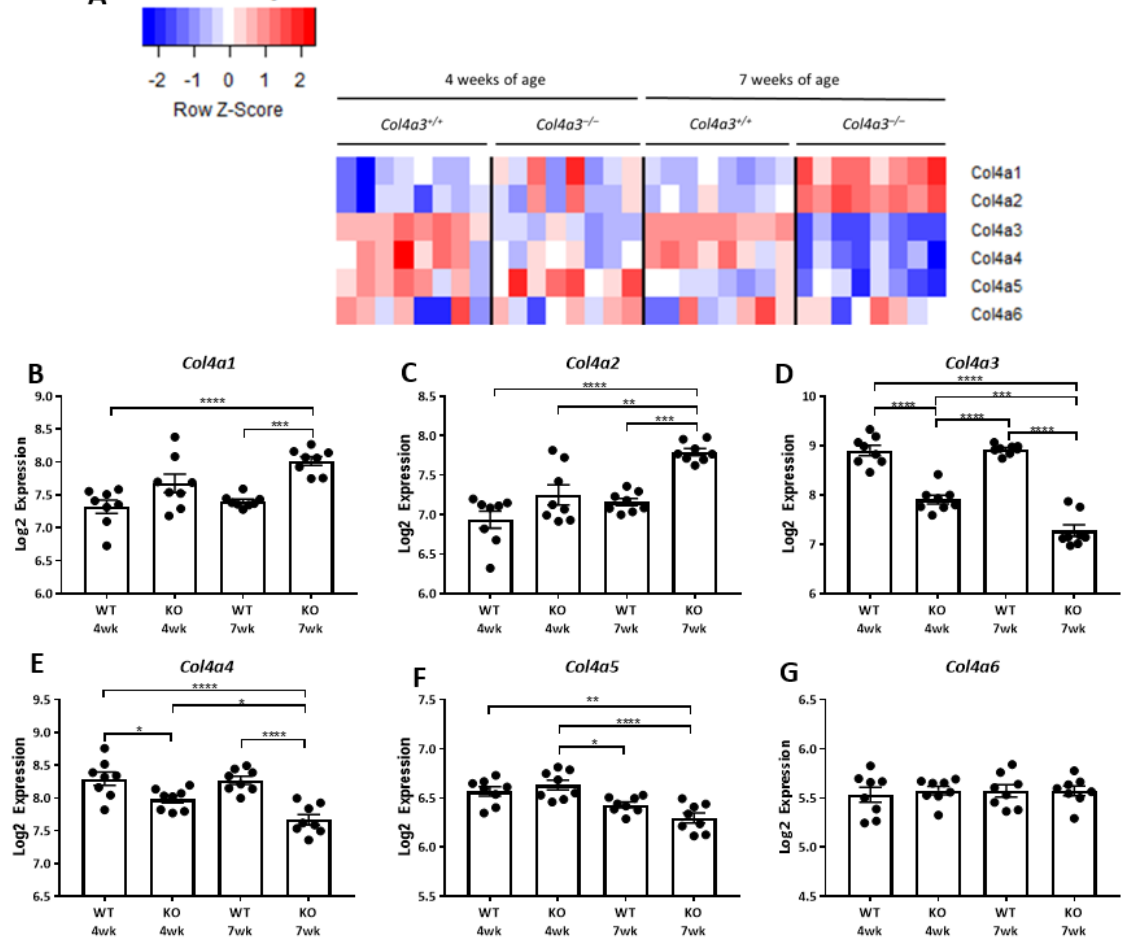
Figure 3. Microarray expression of collagen 4 alpha 1-6. ( A ) Heatmap with unsupervised hierarchical cluster analysis of col4 genes in kidneys of 4 and 7 week old Col4a3 -/- and wild-type mice ( n = 8 per group). Each column reflects a kidney sample, and each row represents an individual gene. Red and blue color intensities correlate with the scaled up-regulation and downregulation of the gene, respectively. ( B – G ) Graphical representation of microarray expression from panel A. Values are mean ± SEM. P values were determined by 1-way ANOVA. * p value < 0.05. ** p value < 0.01. *** p value < 0.001. **** p value < 0.0001.